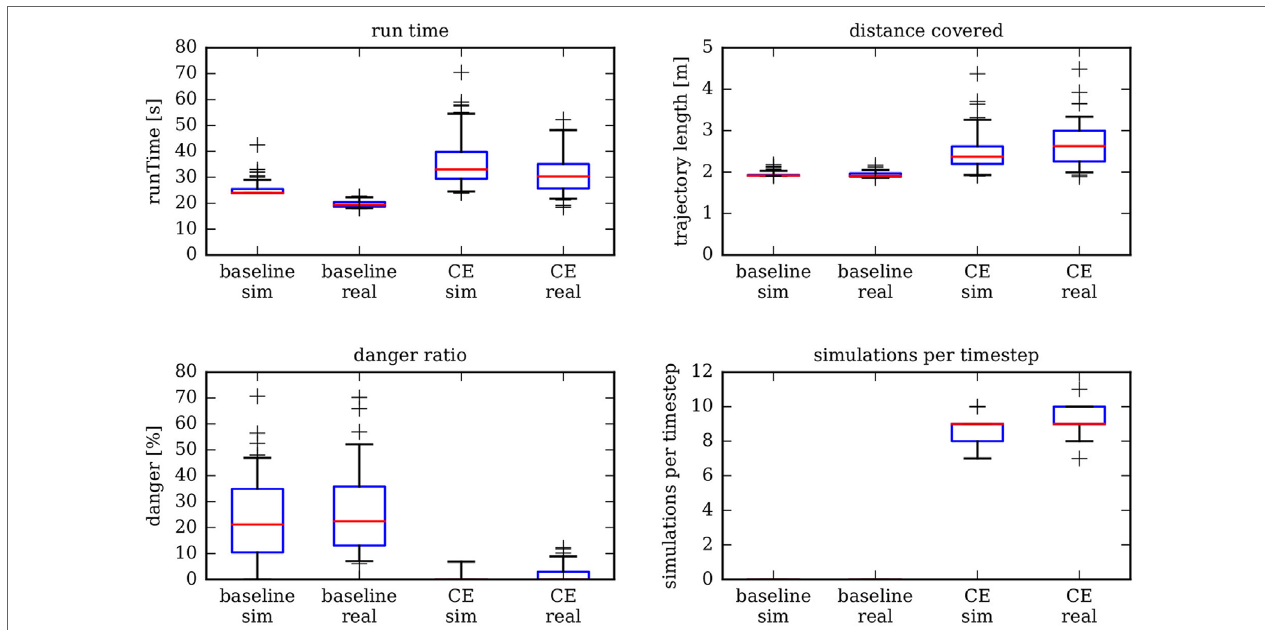
FigUre 13 | Statistical analysis for 88 simulations and 54 real robot experiments considering four basic metrics and comparing them to the baseline experiment. The box plots depict median, 25-quantile, and 75-quantile as a box. Whiskers depict 5-quantile and 95-quantile, and crosses depict data points outside those quantiles.